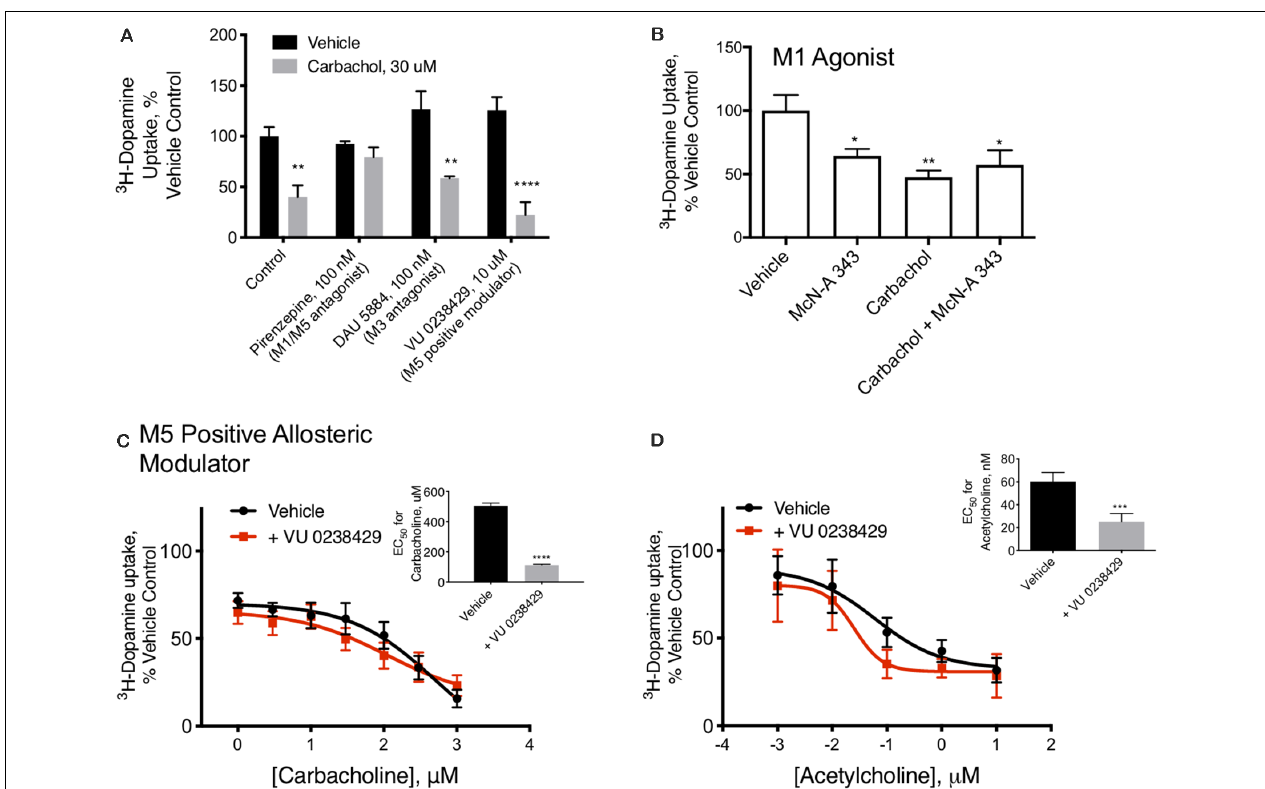
FIGURE 2 | M 1 /M 5 receptors mediate DAT redistribution. (A) In primary midbrain cultures, the effect of carbachol pretreatment on DAT-mediated dopamine transport were was blocked by the M 1 /M 5 antagonist pirenzepine (100 µ M). The M 3 antagonist, DAU 5884 (1 µ M), had no effect ondid not affect the activity of the DAT. The positive M 5 modulator VU 0238429 (10 µ M) potentiated the effects of carbachol ( n = 6, 6, 4, 3, 5, 4, 6, 4, ** P ≤ 0.01 and **** P ≤ 0.0001 by two-way ANOVA). (B) Pretreatment of primary midbrain cultures with the M 1 /M 5 agonist, McN-A-343 (10 µ M), decreased DAT-mediated dopamine transport. McN-A-343 did not demonstrate an additive effect with carbachol, suggesting they are both affecting DAT localization through muscarinic receptor activation ( n = 4, * P ≤ 0.05 and ** P ≤ 0.01 by one-way ANOVA). (C) Co-application of the M 5 -positive modulator VU 0238429 potentiates the effects of carbachol in primary midbrain cultures ( n = 7, *** P ≤ 0.001 by t -test). (D) Acetylcholine-mediated internalization of DAT in primary cultures is also enhanced by co-application of VU 0238429 ( n = 4, *** P ≤ 0.001 by t -test).